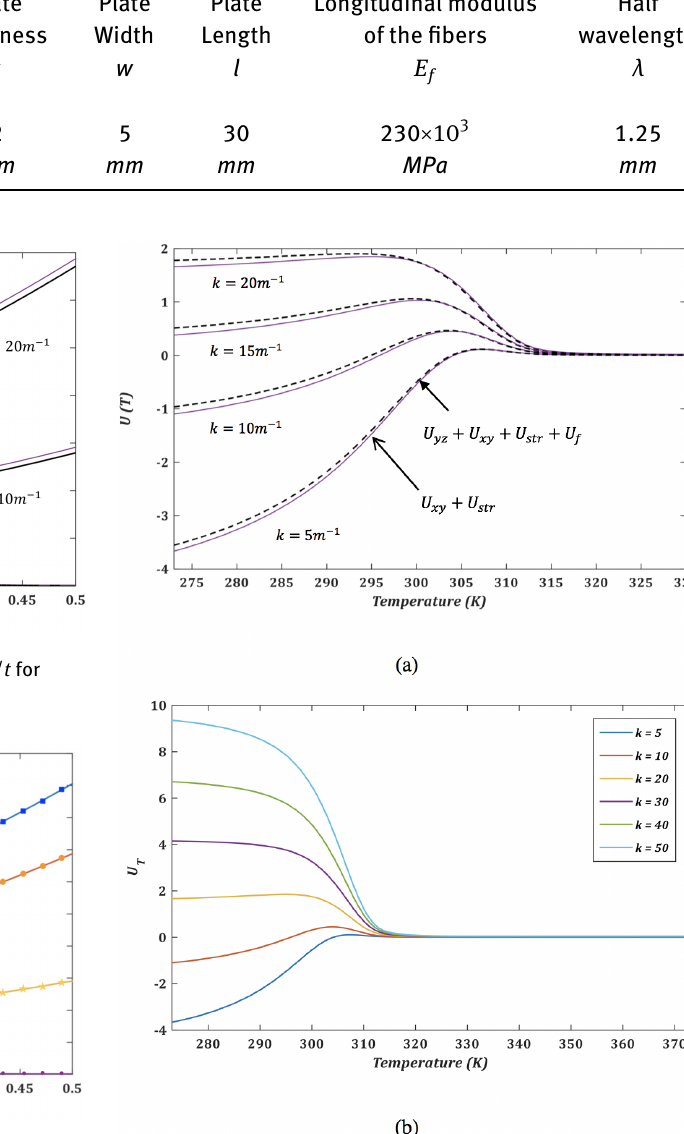
Figure 8: Strain energy of SMPC with respect to z n / t across the glass transition region of the SMP matrix Figure 9: Variation of strain energy with respect to temperature (a) Comparison of total strain energy and sum of U xy and U str (b) Values of U for the values of k from 5 to 50 m −1